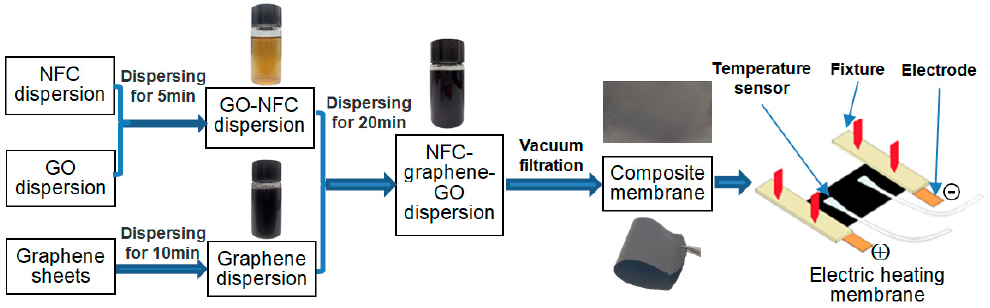
Figure 1. Preparation of the membrane and electric heating device.